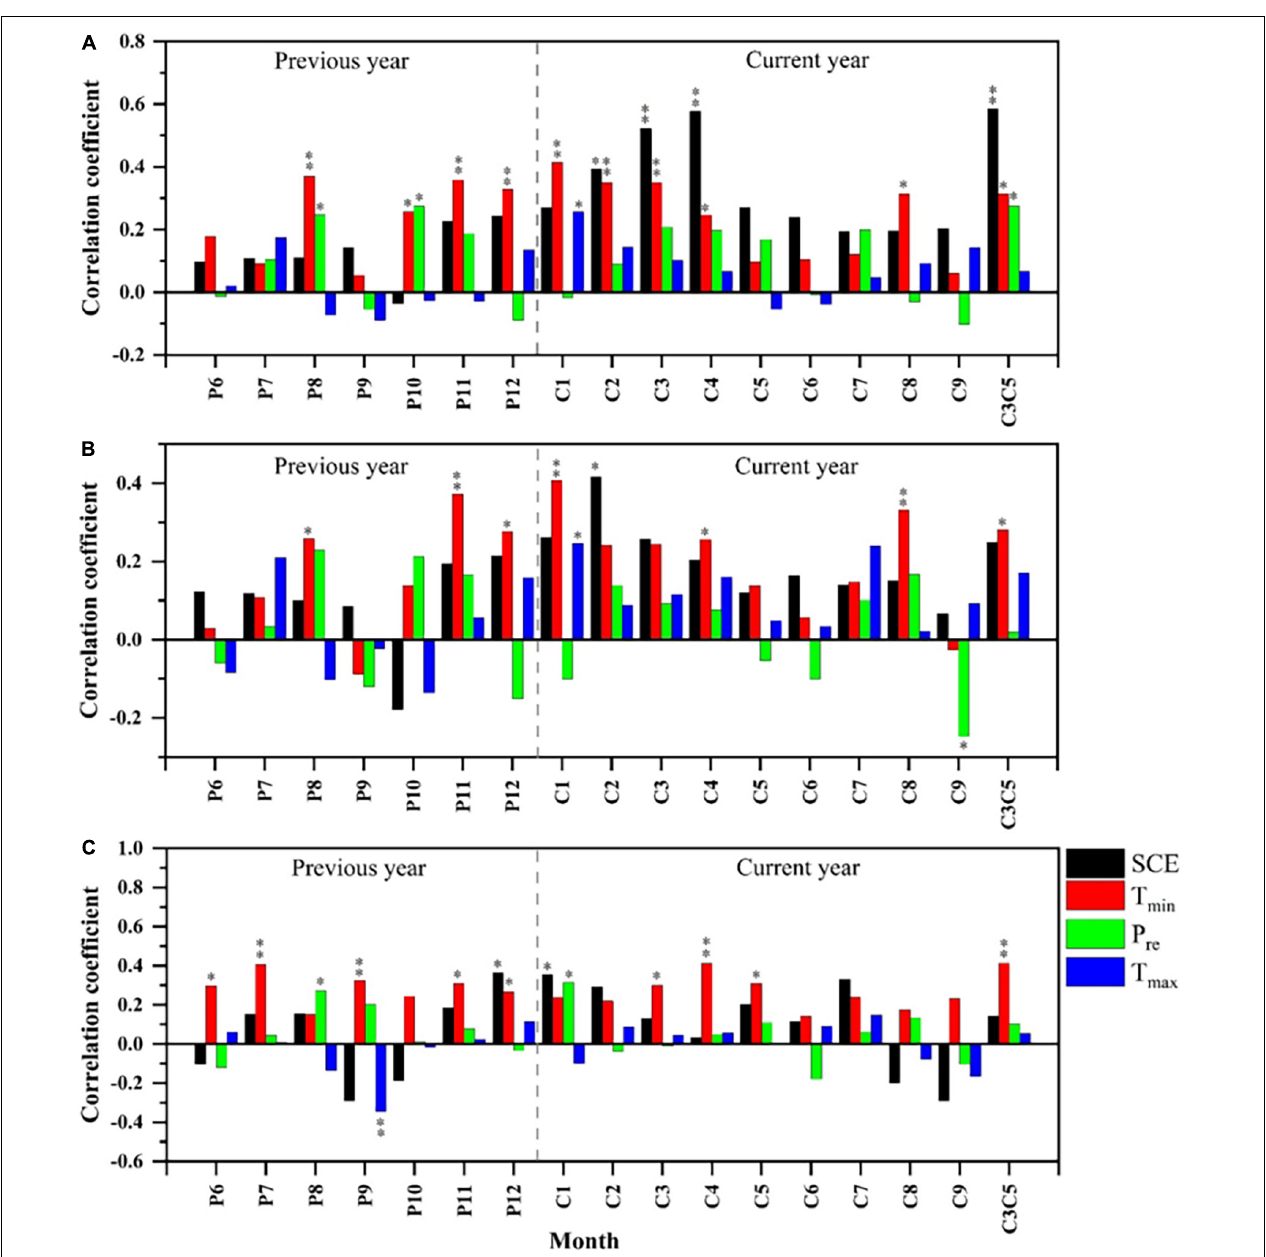
FIGURE 4 | Correlation between (A) EWW, (B) LWW, and (C) TRW chronologies and climatic variables (SCE, T min , and T max ) at XQDV. ** Indicates the significance at the 99% level of confidence and * indicates the significance at the 95% level of confidence.